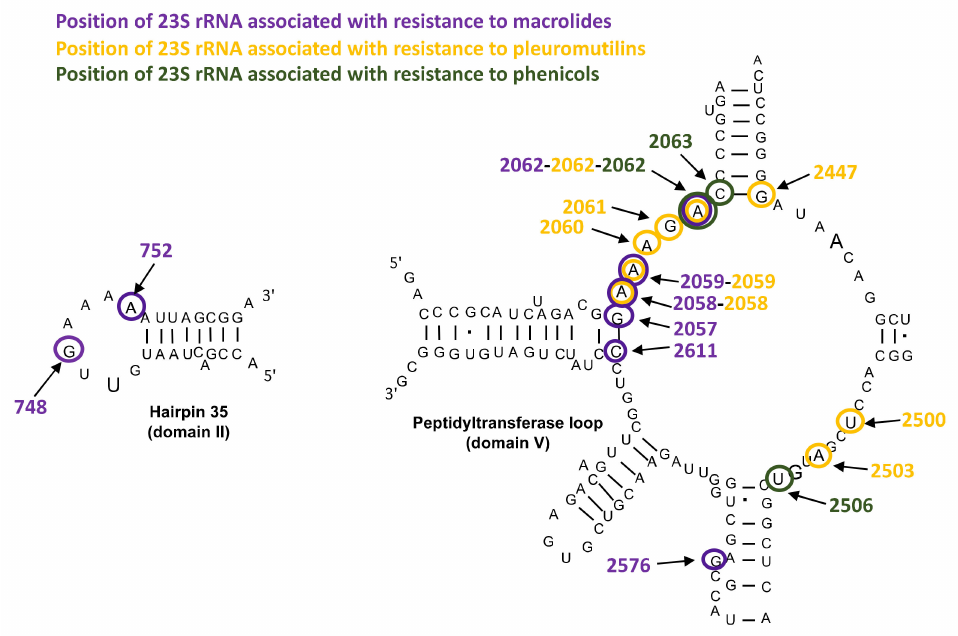
Figure 1. Positions of 23S rRNA mutations associated with macrolide, pleuromutilin and phenicol resistance or loss of susceptibility in human and animal mycoplasmas ( E. coli numbering)